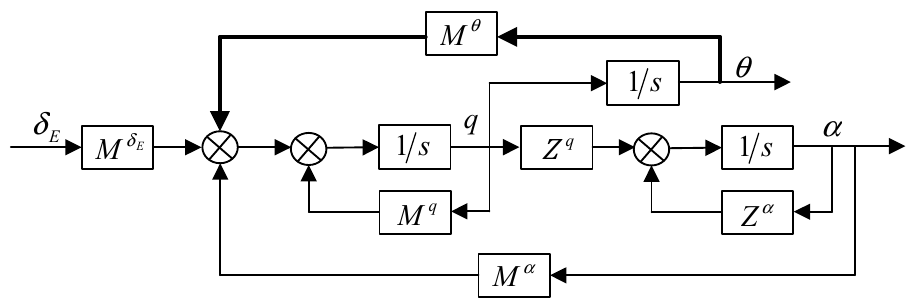
Figure 2. Internal State Structure Diagram of Airship’s Pitch Channel.